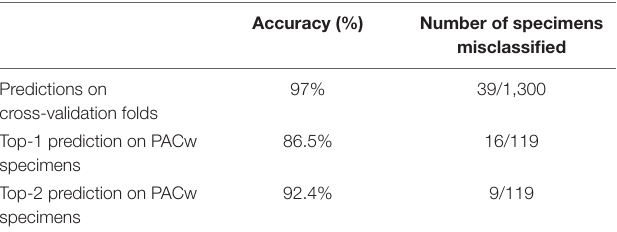
TABLE 3 | Predictive accuracies for the trained models and the corresponding number of specimen-level prediction errors. Accuracy